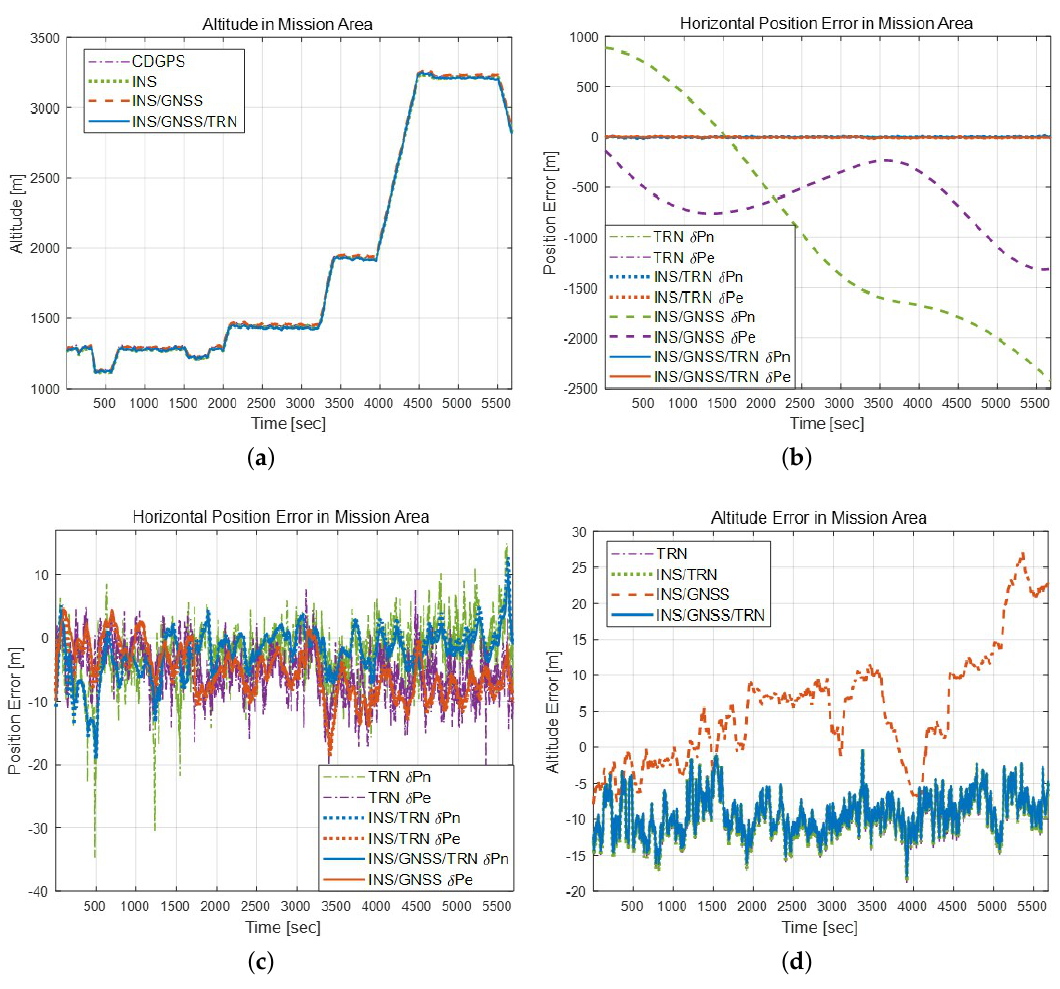
Figure 15. Results of CFT 3 when GNSS is unavailable in the whole area. ( a ) Attitude profile. ( b ) Horizontal position error. ( c ) Horizontal position error without INS/GNSS-aided navigation error. ( d ) Altitude